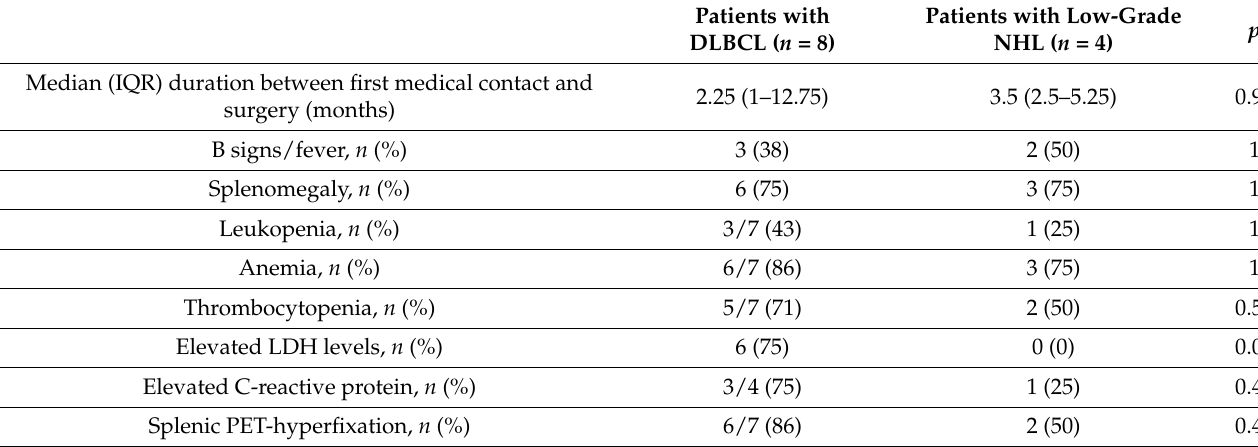
Table 4. Clinical and biological characteristics of patients with DLBCL compared to those with low-grade NHL diagnosed after splenectomy